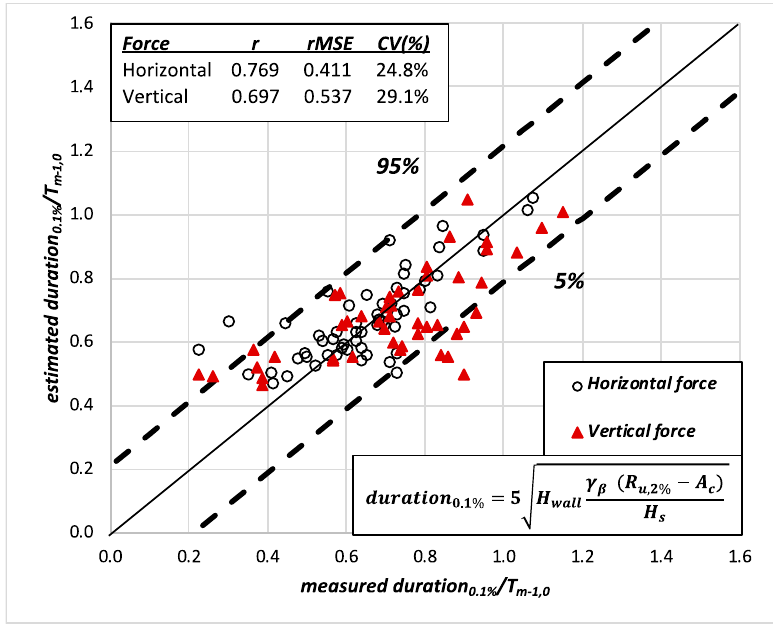
Figure 11. Comparison between the measured dimensionless duration 0.1% ( duration 0.1% /T m-1,0 ) for horizontal and vertical forces.